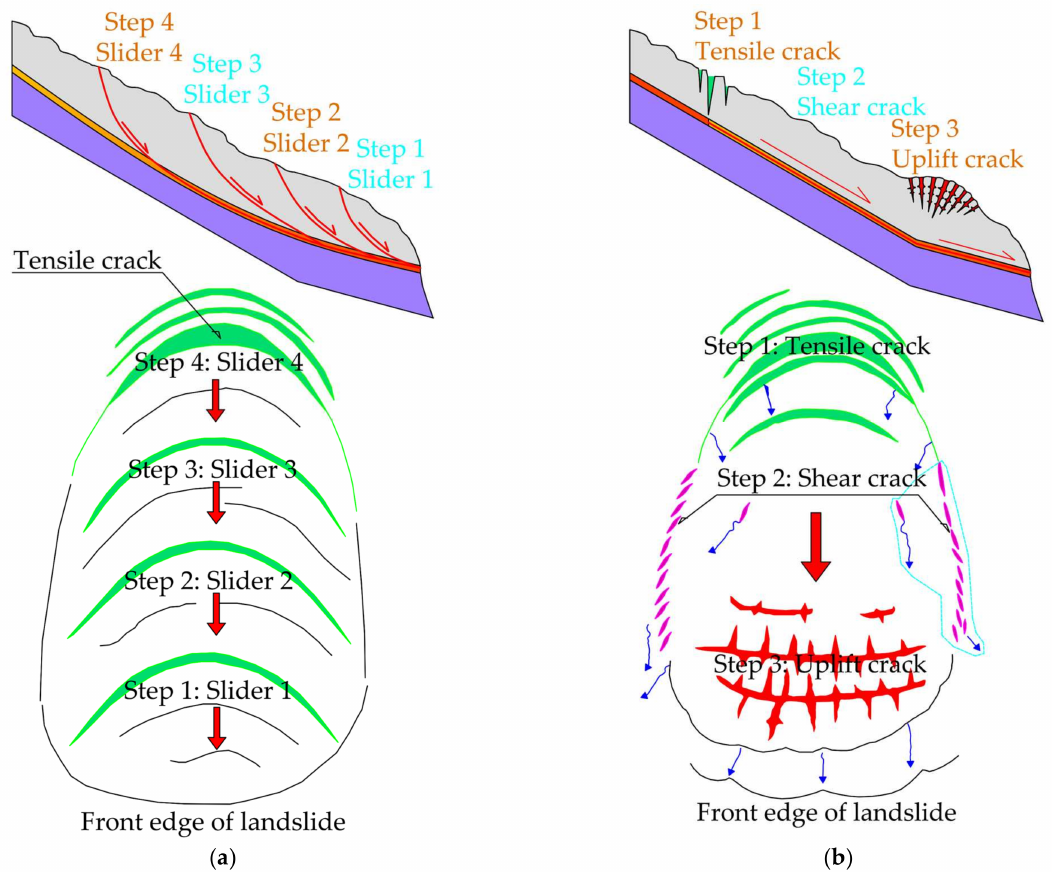
Figure 1. Traditional classification of accumulation landslides. ( a ) Schematic diagram of the classic structural sections of retrogressive accumulative landslides and the staged matching system for surface cracks. ( b ) Schematic diagram of the classic structural section of thrust-load-induced accumulation landslides and the staged matching system for surface